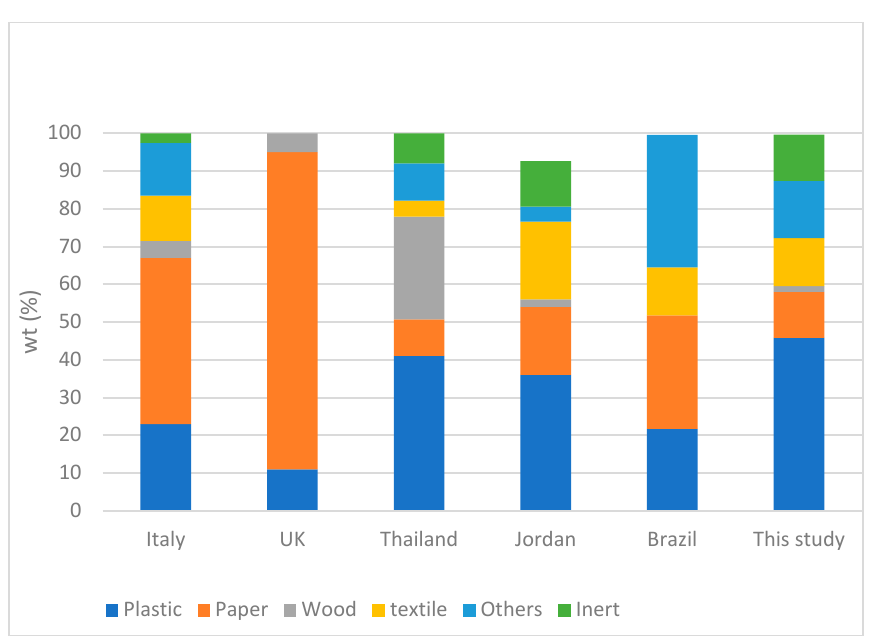
Figure 6. Average composition per unit of RDF from other studies [23,24,27,31].